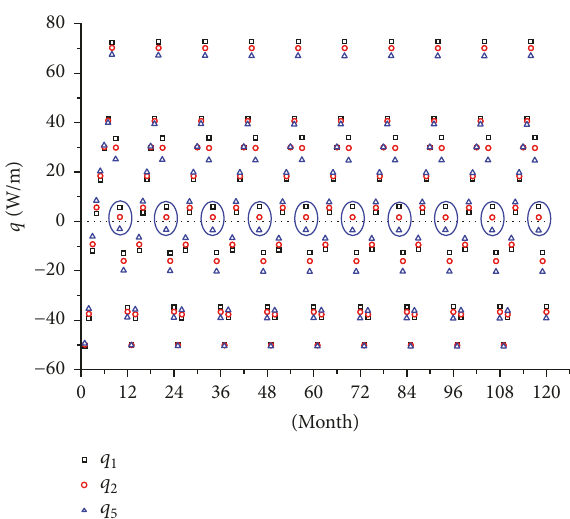
Figure 7: Monthly average heat fluxes for different boreholes (spacing = 4 m).